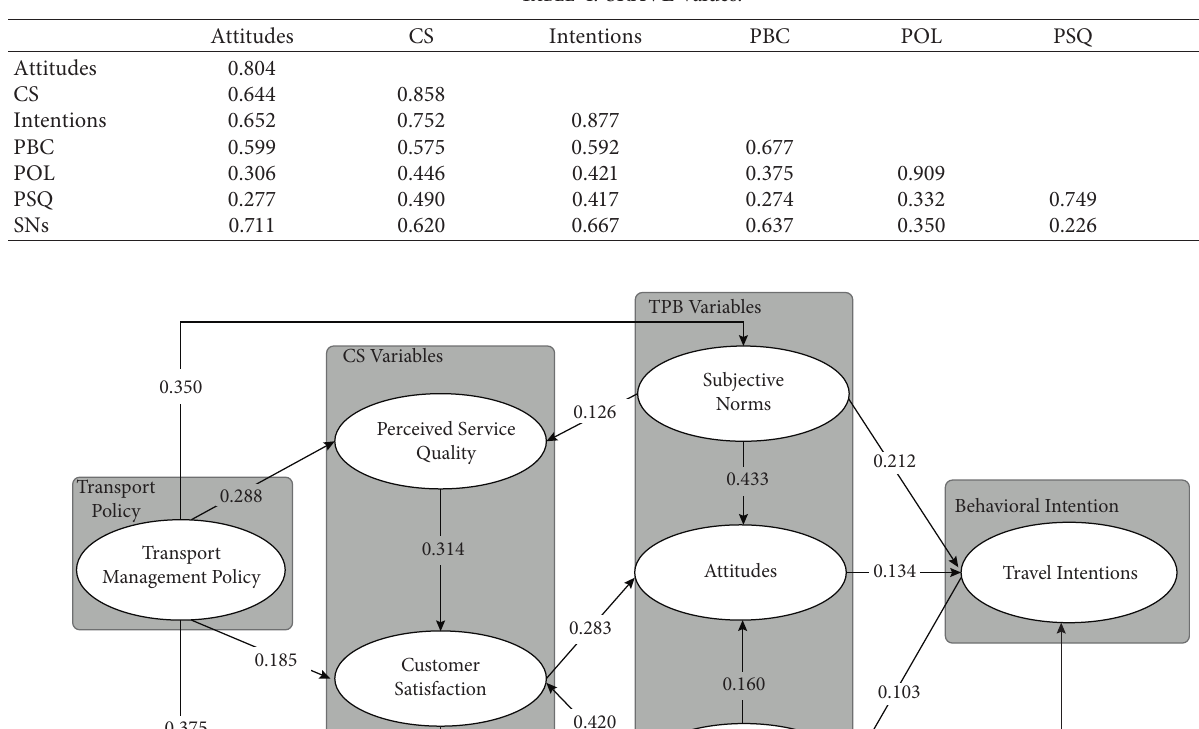
Table 4: SRAVE values.